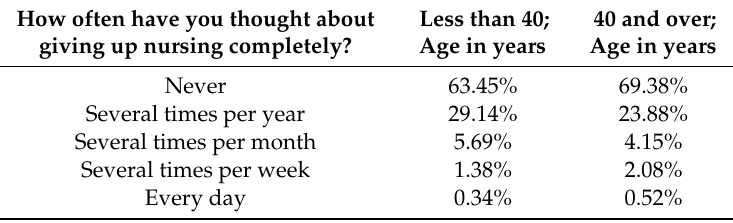
Table 3. Occupational Turnover Intention